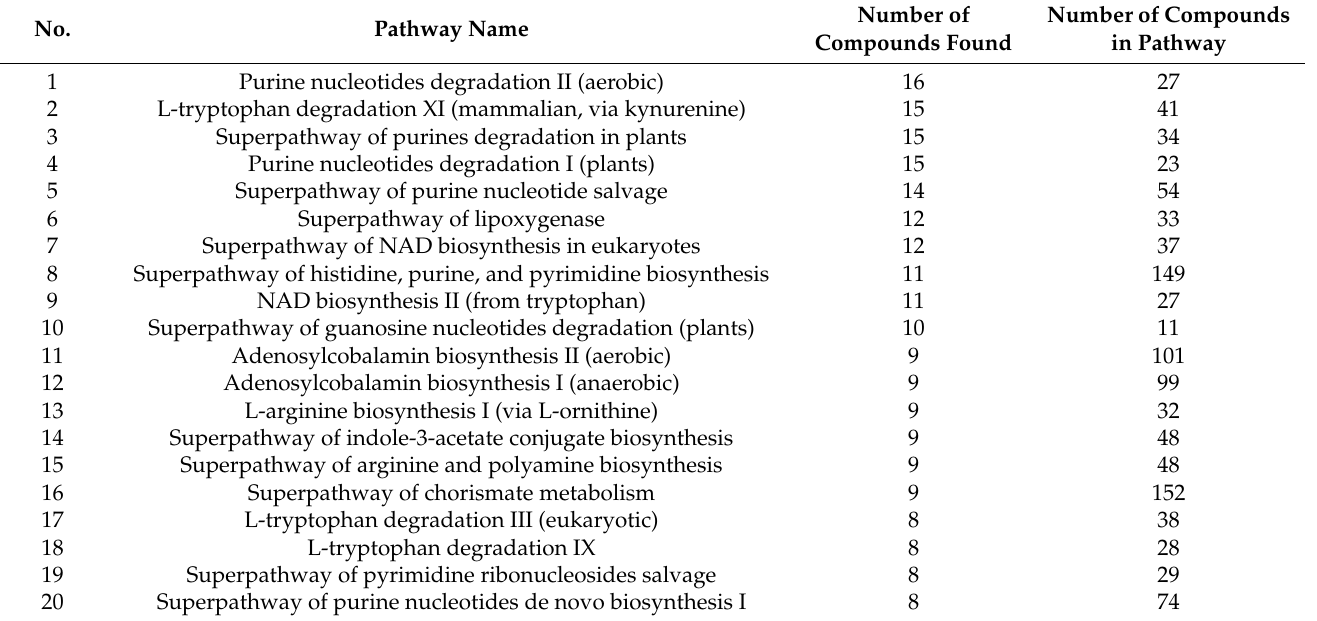
Table 1. List of top 20 pathways from metabolite